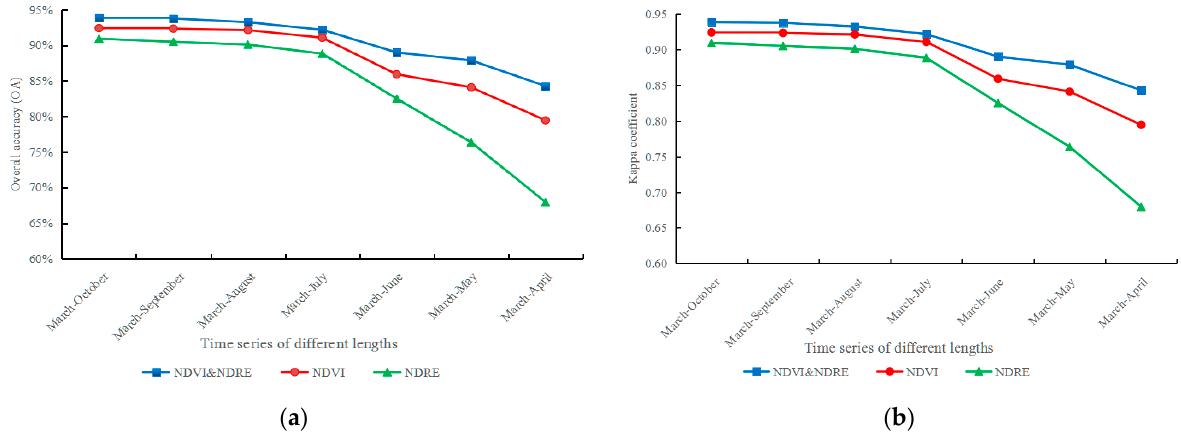
Figure 5. OAs and kappa coefficients curve of three different types and different length vegetation indices time series. ( a ) OAs and ( b ) kappa coefficients.